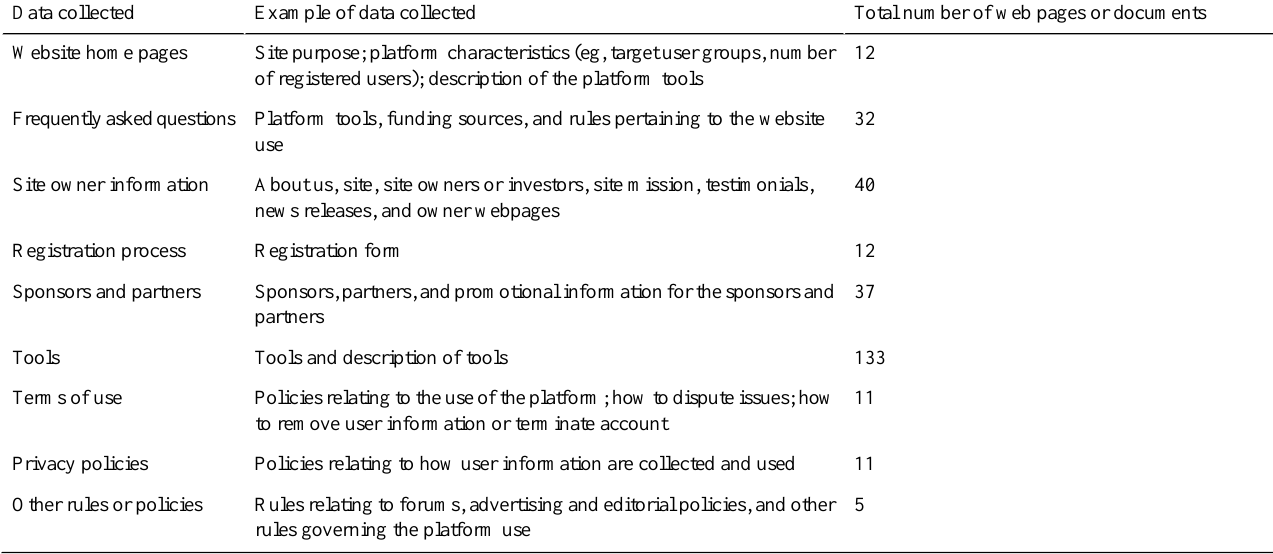
Table 3. Data from website home pages and other